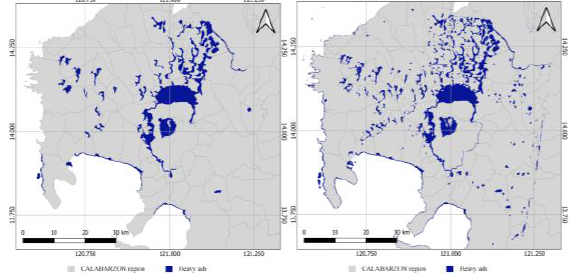
Figure 4. Classified heavy ash over the CALABARZON region before (left) and after (right) post-processing